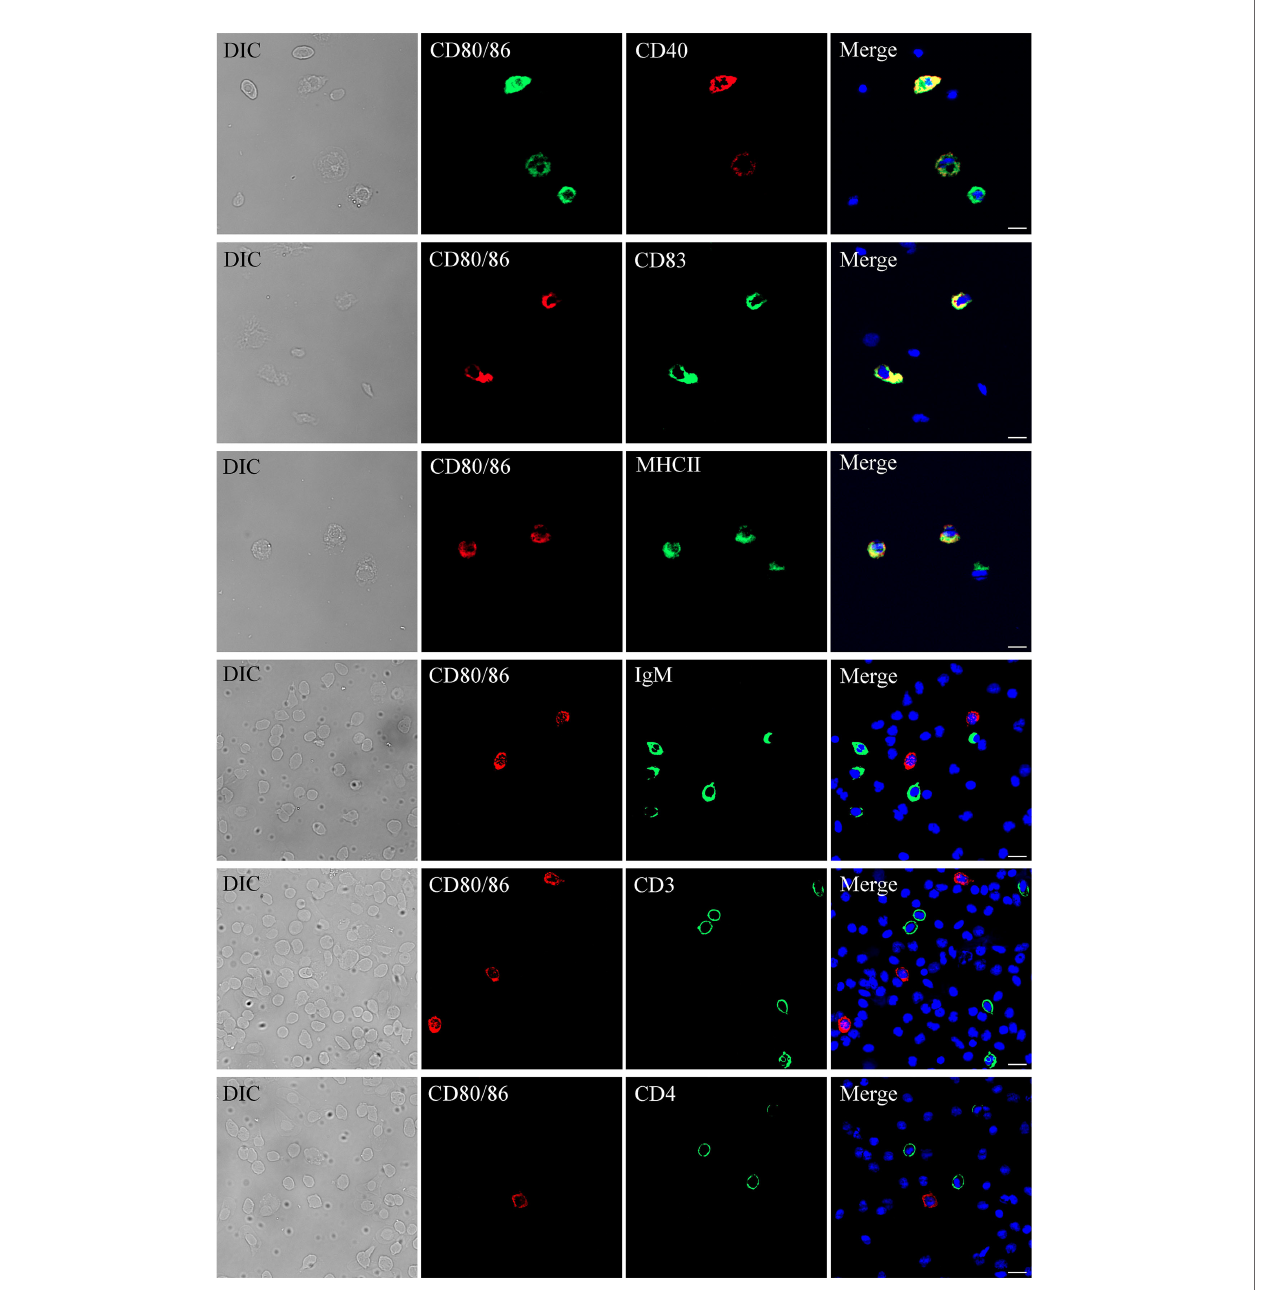
FIGURE 4 | Subcellular localization of CD80/86. The leukocytes were stained with anti-CD80/86 and mouse anti-CD4, rabbit anti-CD3, rabbit anti-CD40, rabbit anti- CD83, rabbit anti-MHCII, or mouse anti-IgM. DAPI staining shows the location of the nucleus. The unimmunized serum was used as negative control (data not shown). The images were obtained using a fl uorescence microscope. Scale bar = 10 m